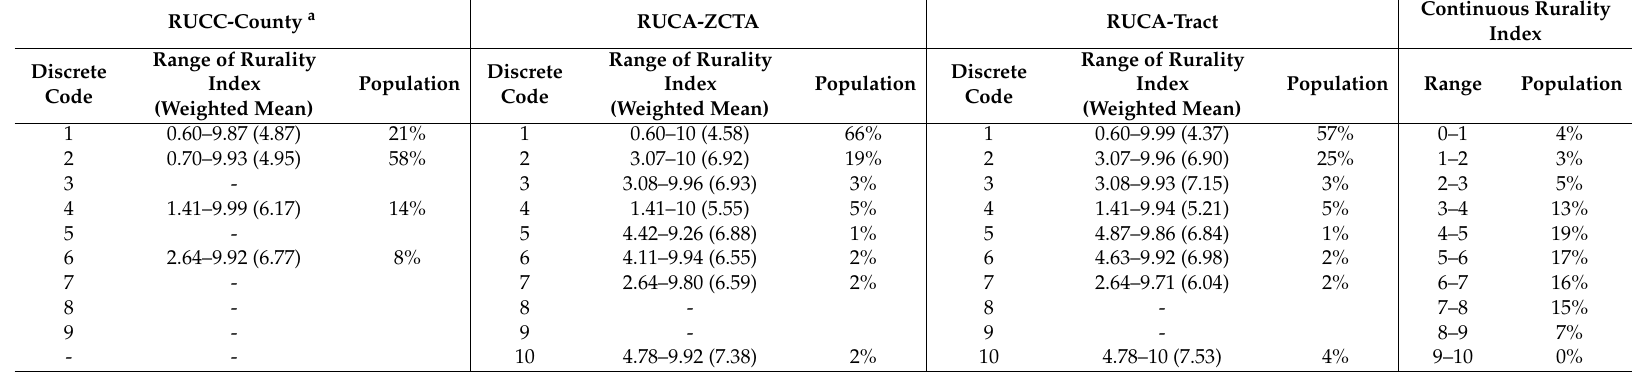
Table 3. Distribution of continuous rurality index in three conventionally used rural-urban